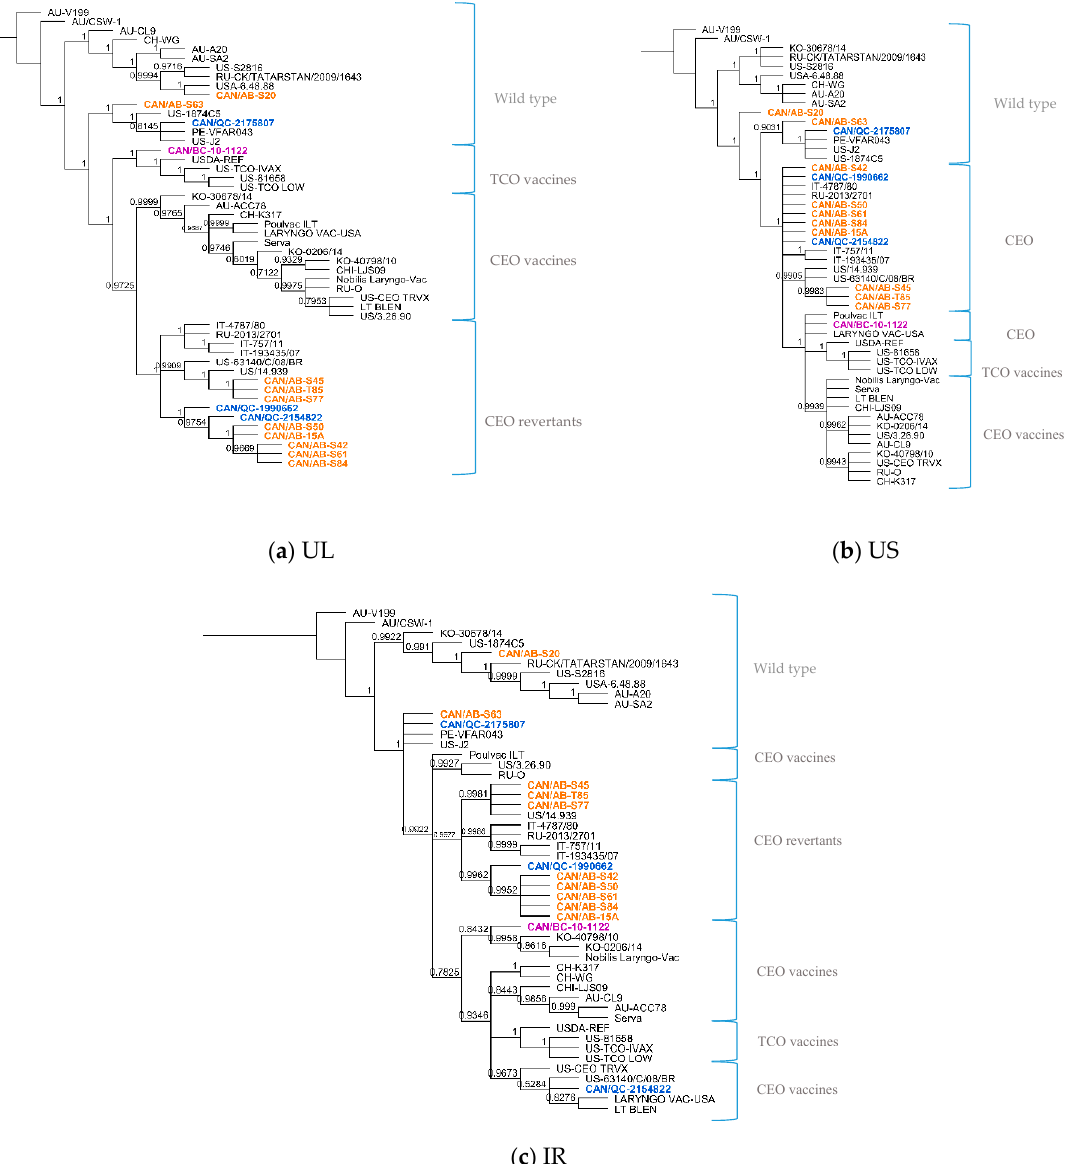
Figure 2. Phylogenetic analysis of 50 ILTV sequences using the unique long region ( a ), unique short region ( b ) and the internal repeat regions ( c ) using the Bayesian inference method (MrBayes, Geneious software). Sequences highlighted in orange represent the Alberta ILTV isolates; in blue, the Quebec ILTV isolates and in purple is the ILTV isolate originated in British Columbia. Brackets and labels to the right of the trees separate and indicate the suggested genotype according to the clustering of the sequences in the phylogenetic trees. Posterior probability values are indicated as branch labels in the tree.